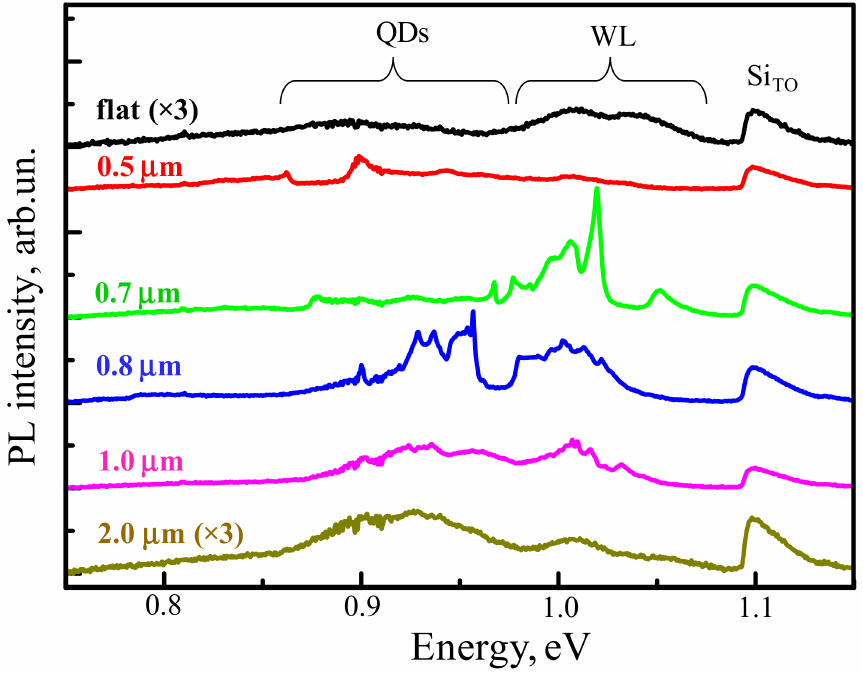
Figure 7. Micro-PL spectra measured in the non-patterned, flat area of structure (black) and pre- patterned areas with pit periods of 0.5 (red), 0.7 (green), 0.8 (blue), 1.0 (magenta) and 2.0 (dark yellow) µ m. The SEM and AFM images of these areas are shown in Figures 4–6. The pit periods are indicated near the corresponding spectra. The signals related to the transverse optical phonon-assisted signal of the Si layer (Si TO ), the wetting layer (WL), and the QDs are indicated. The spectra from the non-patterned area and the area with a period of pits of 2 µ m are multiplied by 3 for clarity. All the spectra were measured at 77